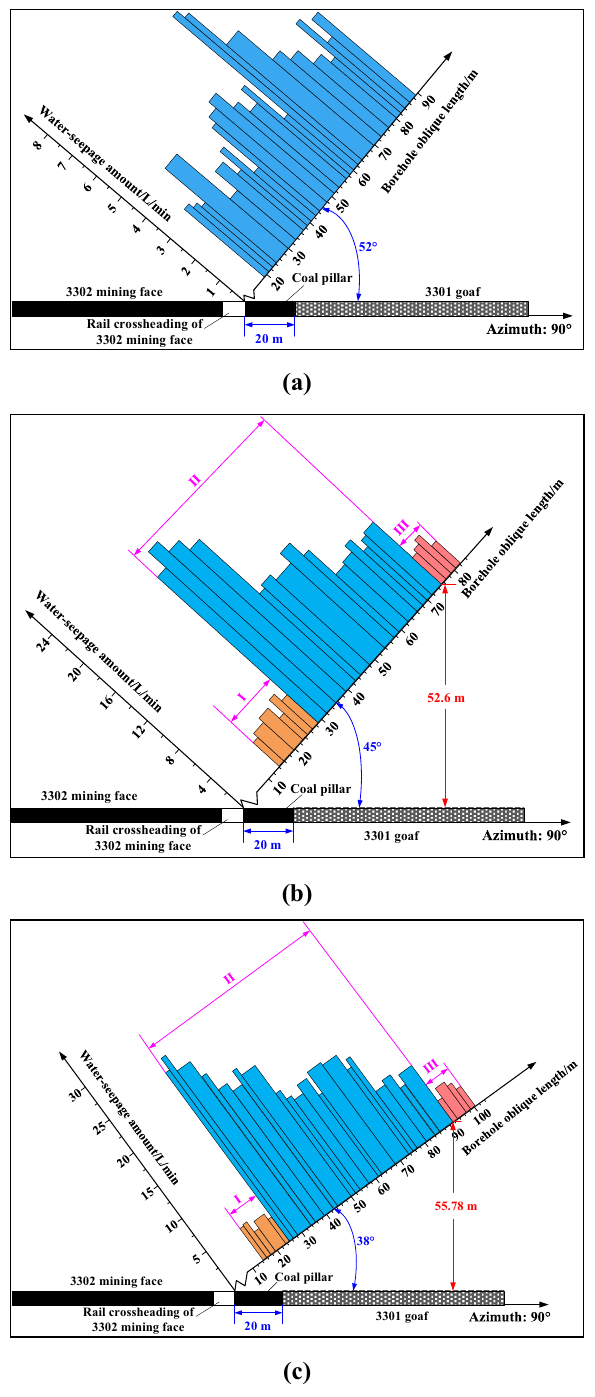
Figure 10. Water seepage histogram: ( a ) Borehole B1, ( b ) Borehole B2, and ( c ) Borehole